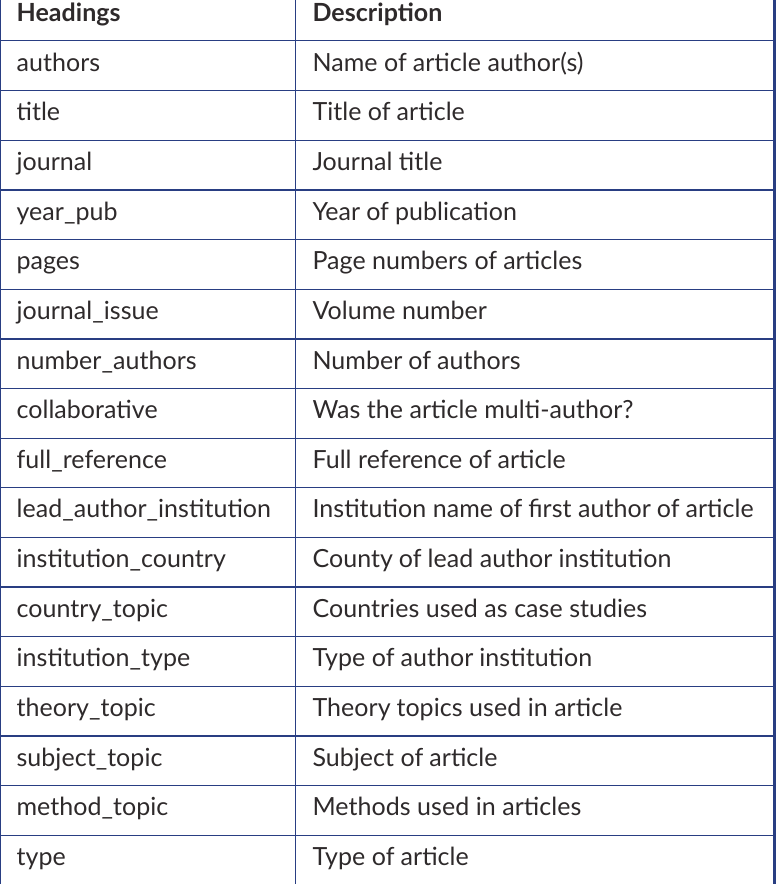
Table 1: Heading and descriptions of fields in the TRAC publication